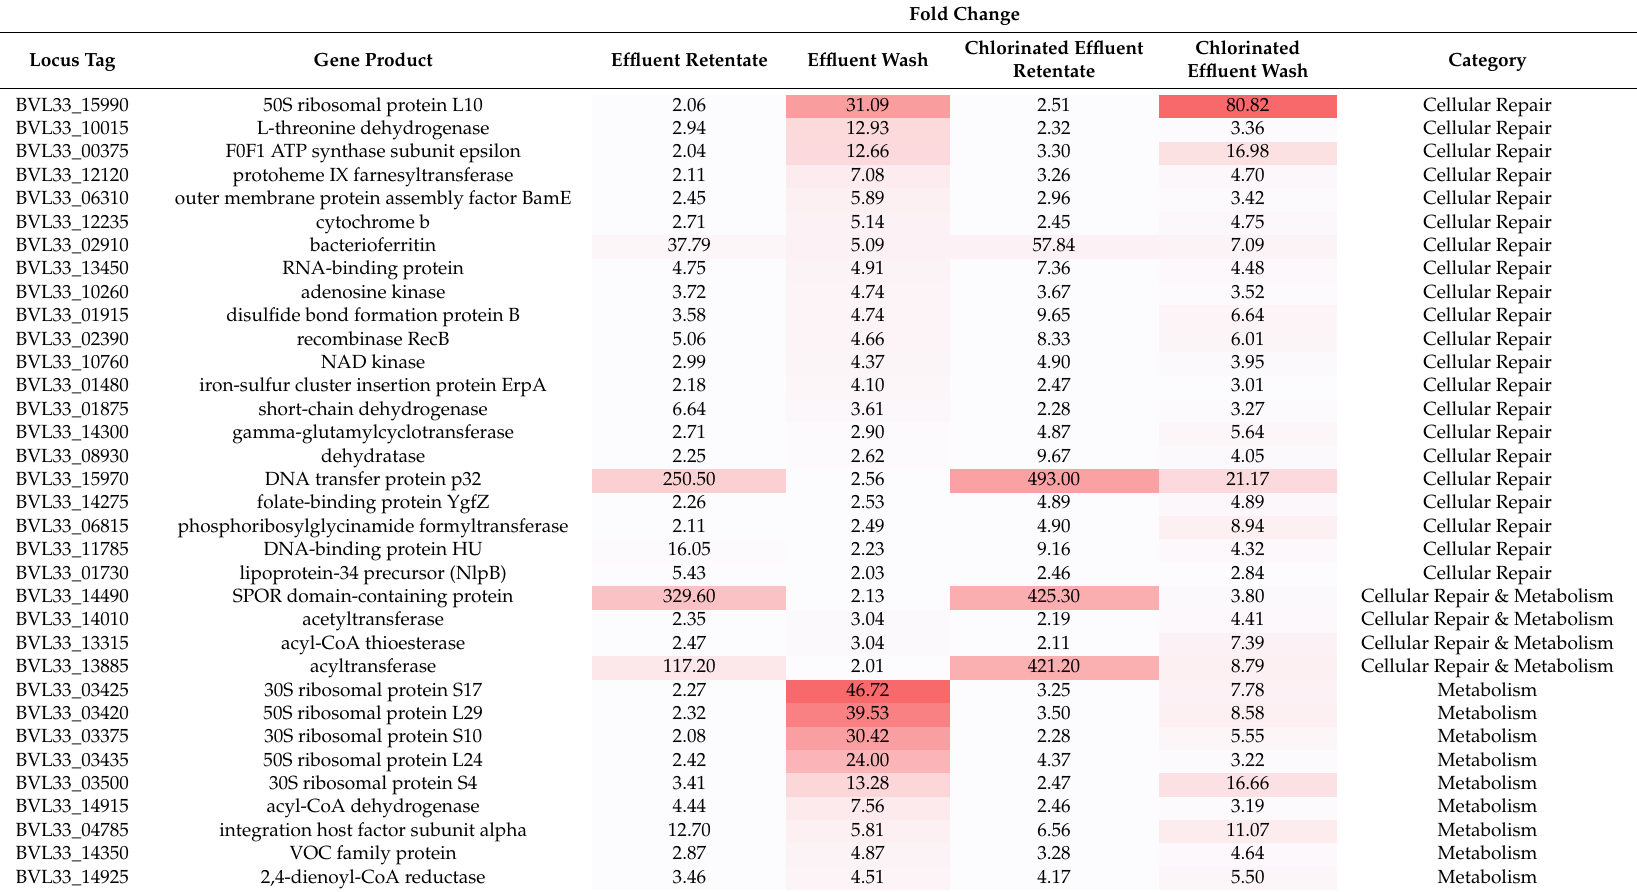
Table 1. Genes of Acinetobacter junii that were upregulated in both the effluent and chlorinated effluent. The gene expression values of the effluent-retentate and chlorinated effluent-retentate were compared to the gene expression values of the influent-retentate. The gene expression values of the effluent-wash and chlorinated effluent-wash were compared to the gene expression values of the influent-wash. Each of these upregulations were included if they were more than two-fold change and were statistically significant ( p < 0.05) on the Baggerly proportion-based test. Genes without any known classifications were omitted. More intense red shading signified a high fold